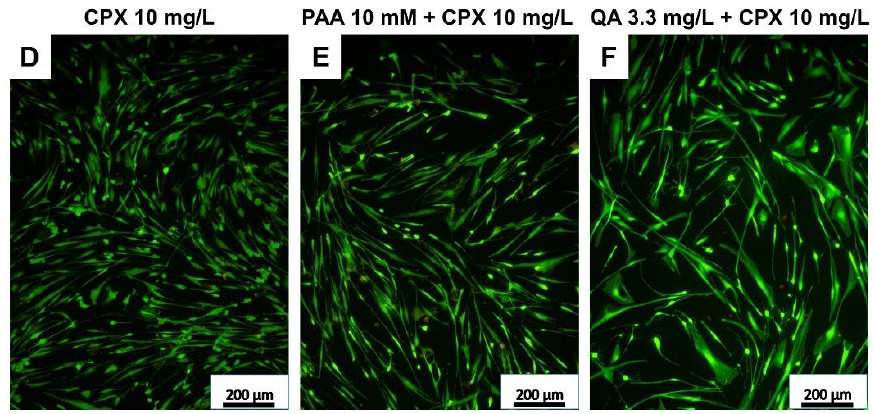
Figure 3. Live/dead staining of human tenocytes after treatment with PAA, QA, CPX, alone or in combination with CPX, for 72 h. Representative images are shown. ( A ) Untreated control, ( B ) PAA 10 mM, ( C ) QA 3.3 mg/L, ( D ) CPX 10 mg/L, ( E ) PAA 10 mM + 10 mg/L CPX, ( F ) QA 3.3 mg/L + CPX 10 mg/L. Living cells—green, dead cells—red. Scale bars = 200 µm.